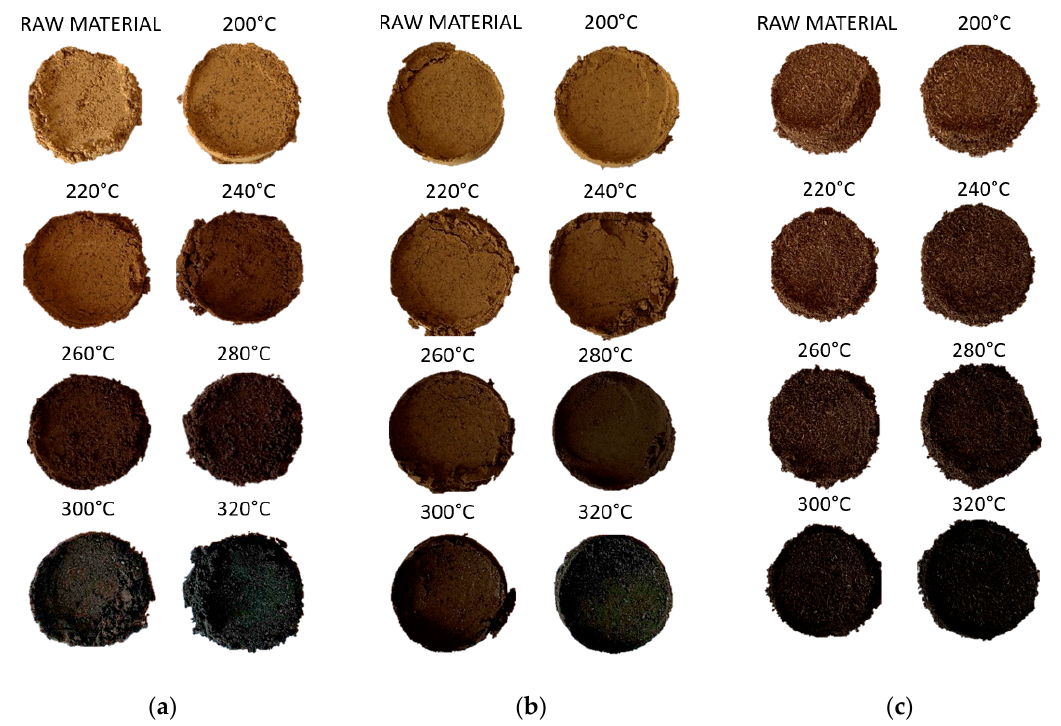
Figure 5. Color change in the material depending on the torrefaction process temperature: ( a ) horse chestnuts; ( b ) oak acorns; and ( c ) spruce cones.